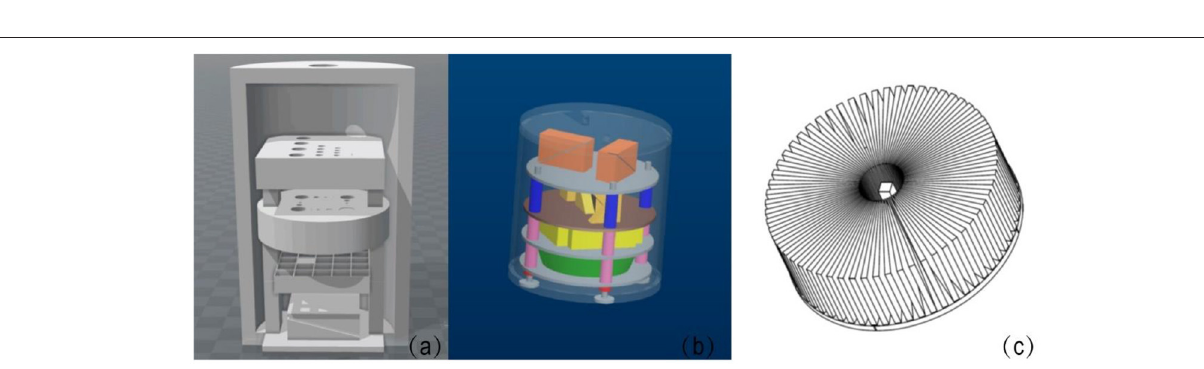
FIGURE 2 | (a) Shows a schematic of the phantom model. (b) Shows a phantom design with internal layers and inserts in a transparent shell (PMMA). The peripheral support posts can be seen along the periphery of the phantom (blue, pink, and red components). (c) Shows a schematic of a star-shaped phantom internal layer designed for modulation transfer function (MTF) evaluation for